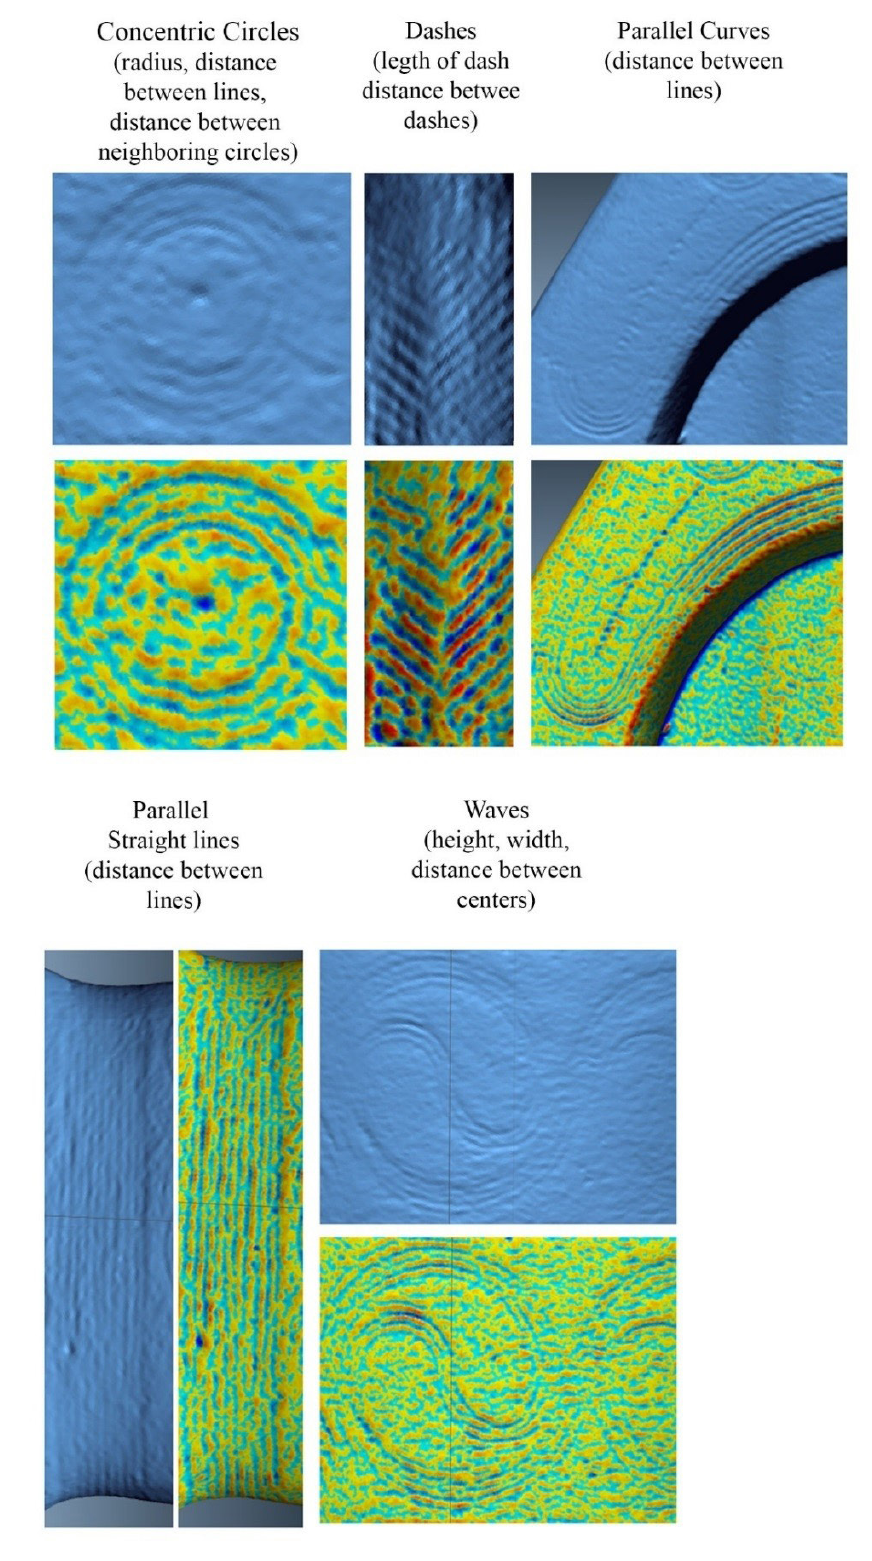
Figure 4. Examples of each type of decorative shape data